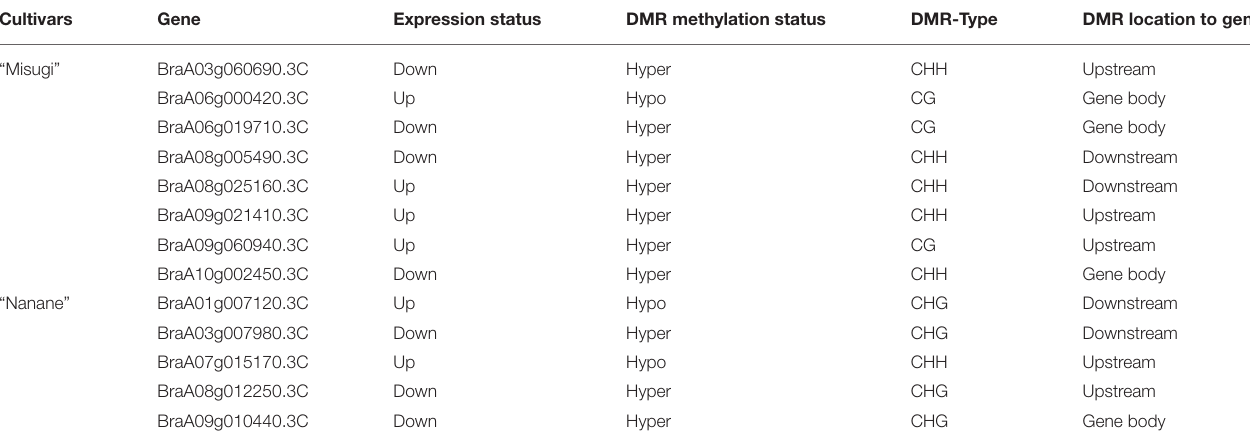
TABLE 3 | The status of 13 differentially expressed genes (up/downregulation) and their association with differentially methylated regions (DMRs) in B. rapa cultivars “Misugi” (susceptible) and “Nanane” (resistant).